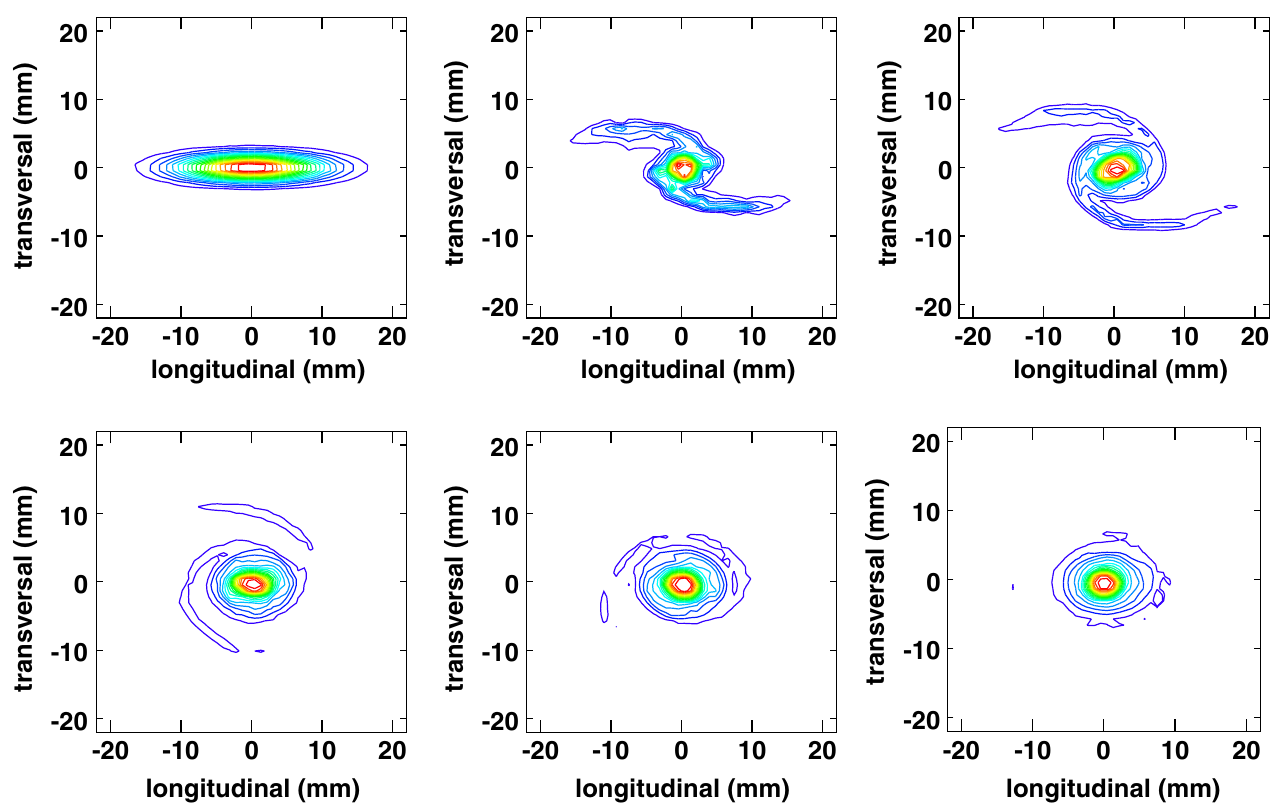
FIG. 7. (Color) Top view of a 1 mA, 3 MeV coasting beam in PSI injector II in the local frame S Down: turn 20, 30, 40. To compare with figures in Ref. [30], the beam’s transport direction is along the negative direction of the abscissa